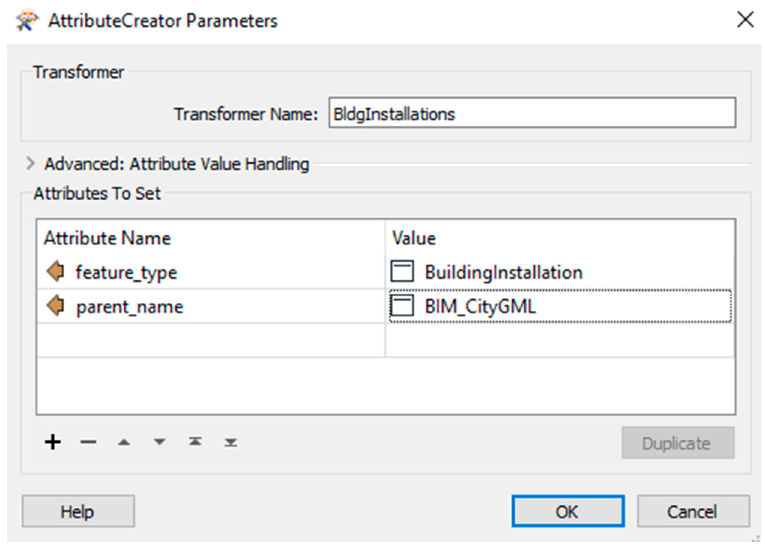
Figure 8. AttributeCreator Parameter LOD3 BuildingInstallation.